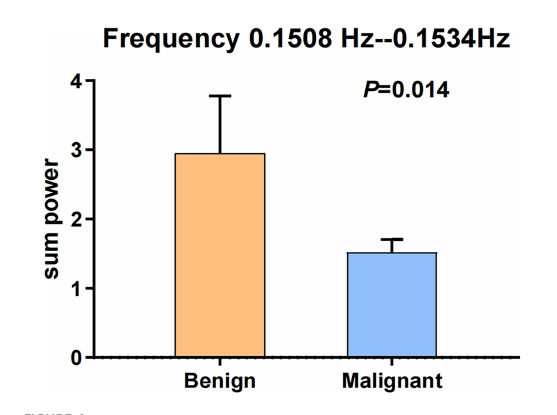
FIGURE 4 The error bars of two sample t -test after merging the two frequency points of 0.1508 and 0.1534 Hz. The sum power of benign MSK tumors was signi fi cantly higher than that of malignant tumors. P -value is